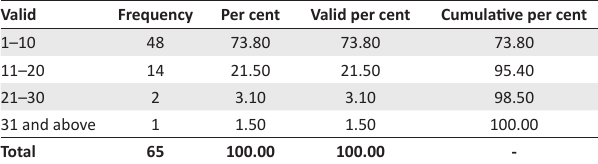
TABLE 3: Frequencies of participants’ years of public